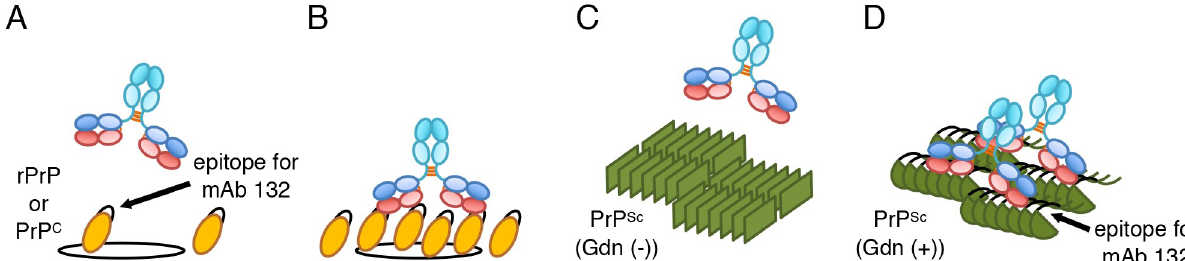
Fig 9. Mechanism for PrP Sc -specific detection by mAb 132. (A, B) Binding of mAb 132 to rPrP and PrP C molecule. mAb 132 inefficiently binds to PrP molecule if density of PrP molecules is lower than that allows bivalent binding because of low affinity of monovalent binding of mAb 132 (A), whereas mAb 132 binds stably to PrP molecules by avidity effect if the density of PrP molecules is high enough to allow bivalent binding (B). Orange ovals: rPrP or PrP C ; black lines on the orange ovals: epitope for mAb 132. Circles indicates the area where bivalent binding of intact mouse IgG 1 takes place. (C, D) Binding of mAb 132 to PrP Sc oligomer/aggregate. mAb 132 does not bind to PrP Sc without guanidinium salt pretreatment (C, Gdn (-)), whereas epitopes for mAb 132 are exposed by the guanidinium salt pretreatment (D, Gdn (+)), multiple epitopes for mAb 132 on the PrP Sc oligomer/ aggregate allow bivalent binding of mAb 132 (Gdn